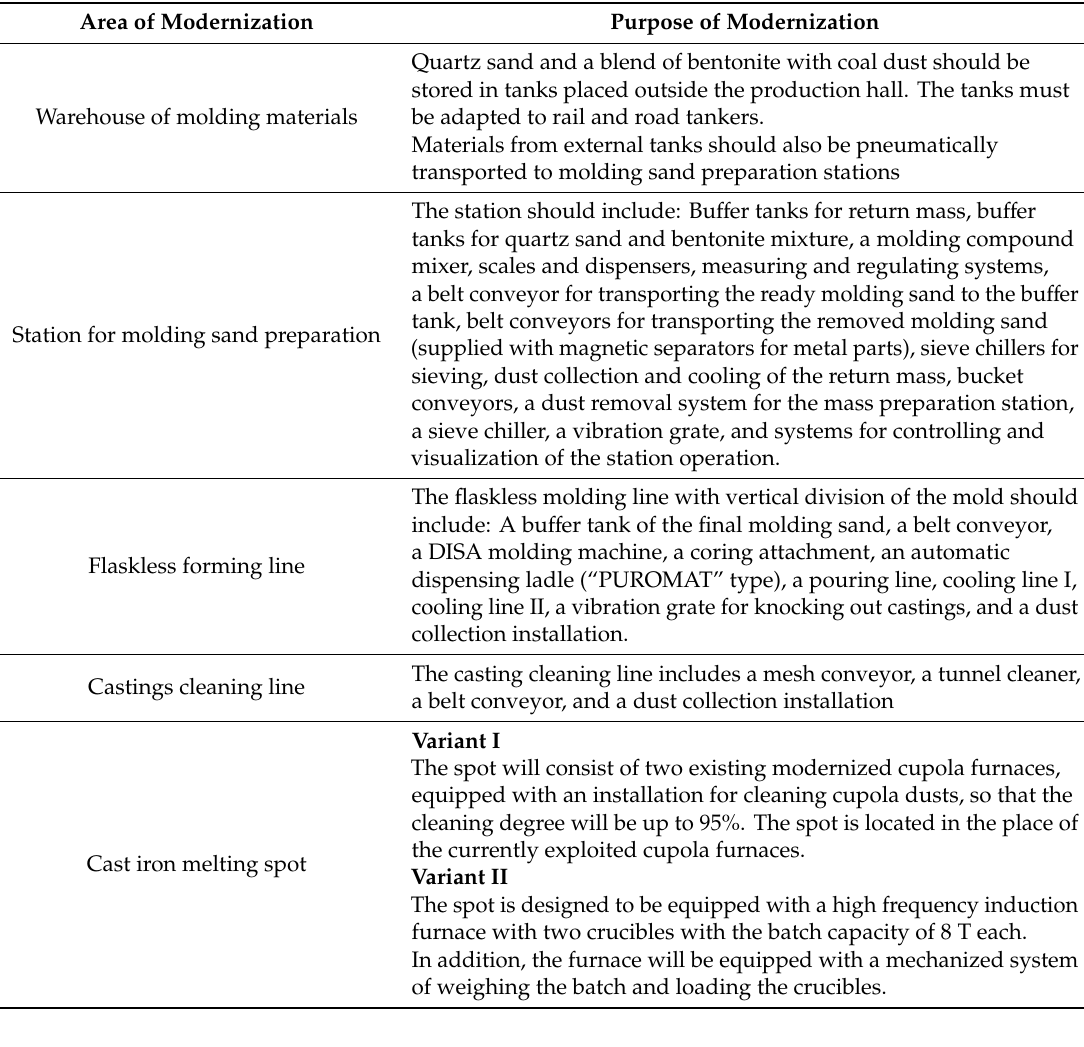
Table 3. Areas and purposes of modernization.